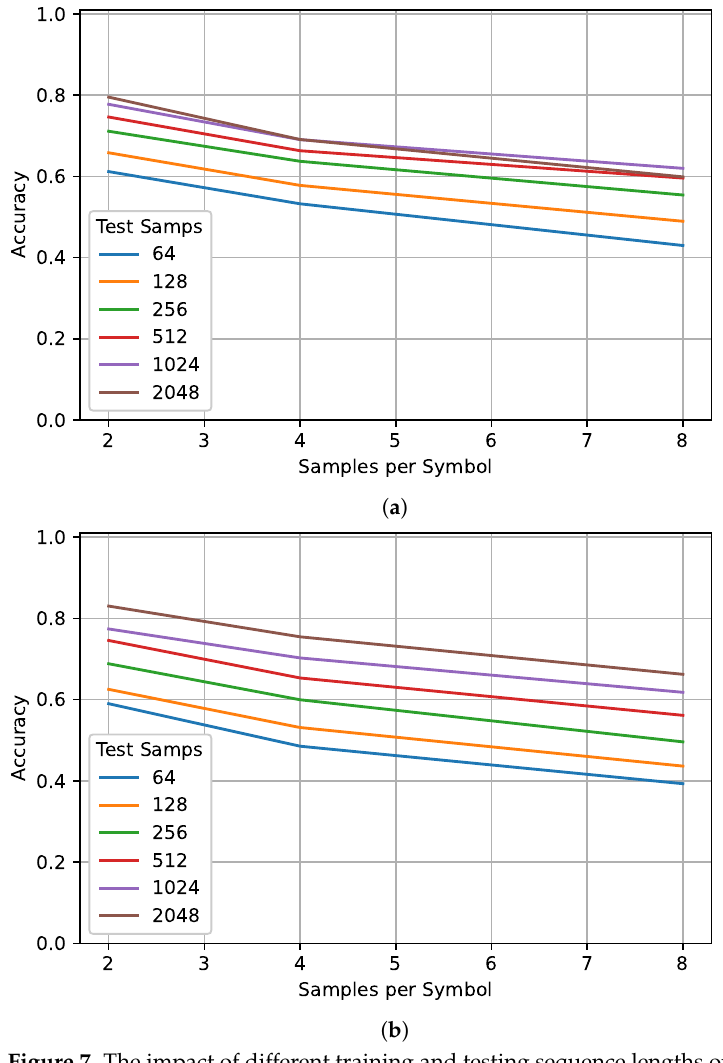
Figure 7. The impact of different training and testing sequence lengths on performance for different oversampling rates. Sequence lengths of 64, 128, 256, 512, 1024, and 2048 were tested on the best network trained on ( a ) 128 samples and ( b ) 1024